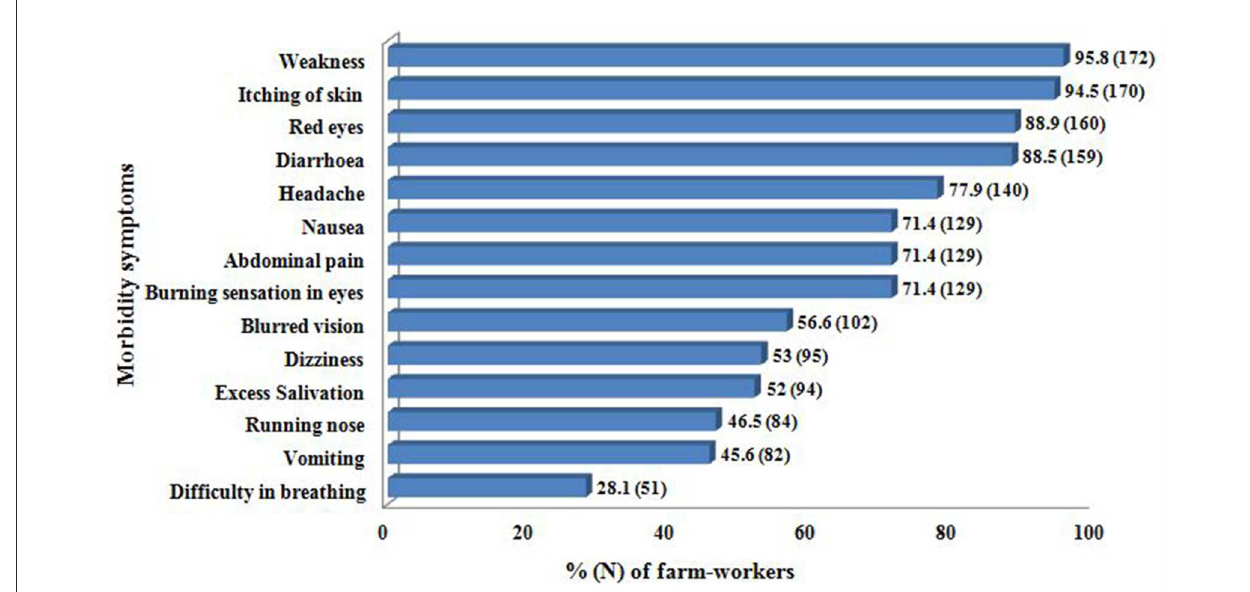
FIGURE3 Pesticide poisoning self-reported morbidity symptoms by farm-workers ( n = 180).